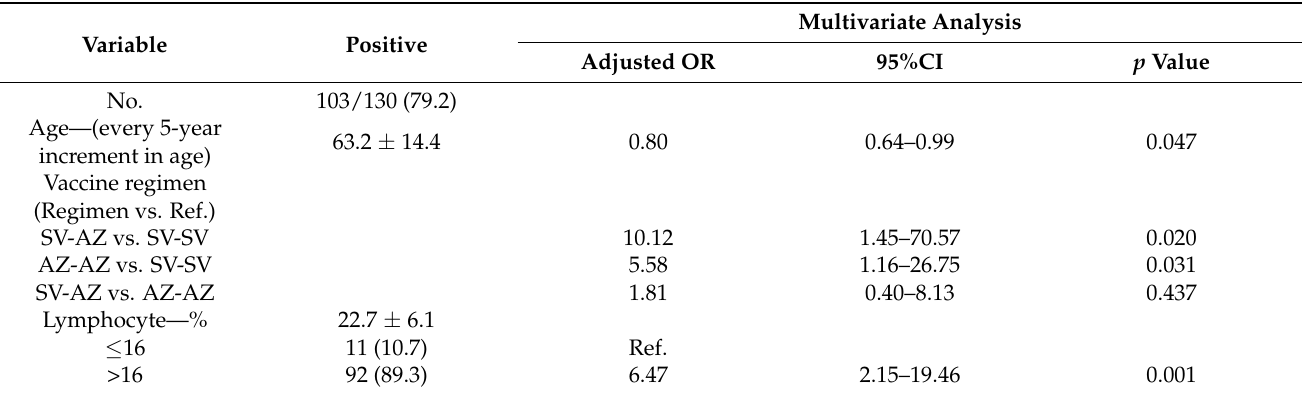
Table 3. Multivariate analysis of factors associated with the seroconversion measured by sVNT among maintenance hemodialysis